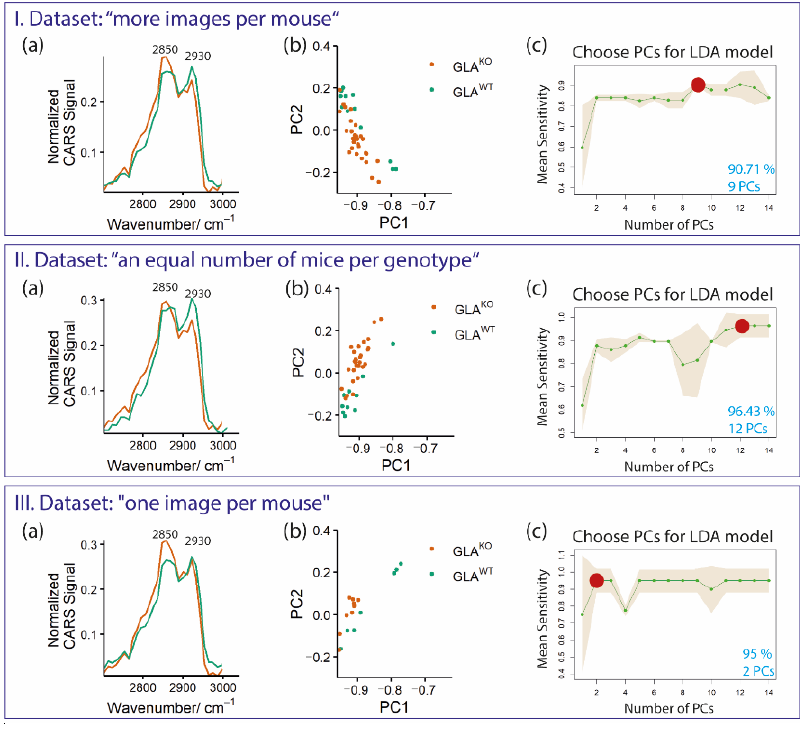
Figure 4. Statistical variations and data analysis of CARS images of heart tissue sections of a Fabry disease mouse model for three different datasets: ( I ). 20 GLA WT vs. 35 GLA KO (“more images per mouse”); ( II ). 10 GLA WT vs. 28 GLA KO (“an equal number of mice per genotype”); ( III ). 8 GLA WT vs. 10 GLA KO (“one image per mouse”). Shown is ( a ) a mean spectrum for each genotype; ( b ) PCA results (PC1 vs. PC2 for both genotypes); ( c ) PCA-LDA model based on leave- one-mouse-out cross-validation between both genotypes, demonstrating the mean sensitivity with standard deviation (depicted as a brown shadow; y -axis) for different numbers of PC included in the calculation ( x -axis). The mean sensitivity was calculated as the average of all sensitivities for each genotype. The highest classification sensitivity in % and the number of PCs that are at least required to achieve this sensitivity are marked with a red dot, and the calculated value is indicated in